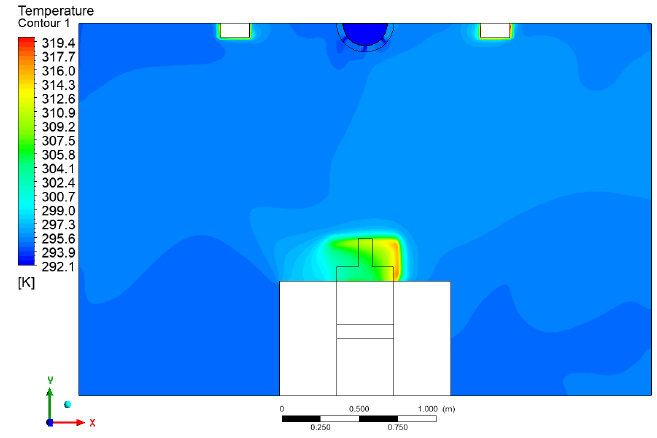
Figure 24. The temperature distribution of the X = 2 m section.